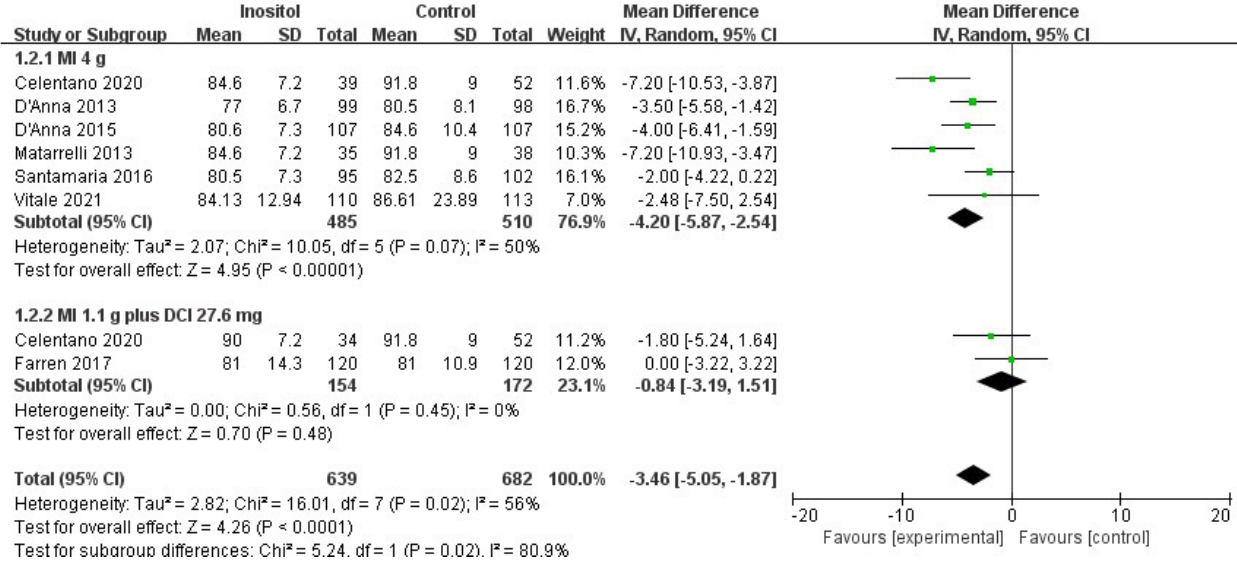
Figure 5. Inositol vs. control: fasting-glucose OGTT [14–20].